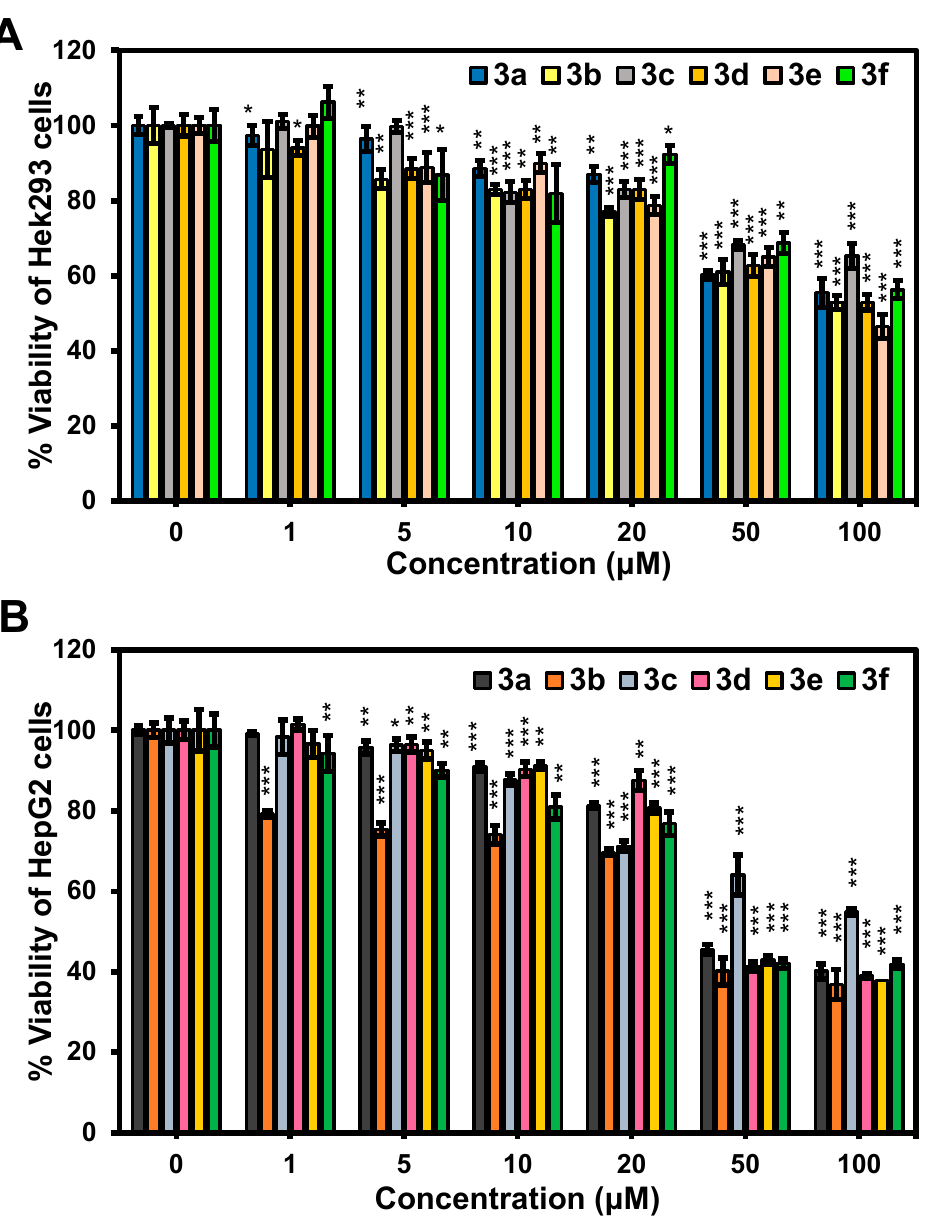
Figure 5. Cytotoxicity effect of chalcones 3a – f on the cellular viability of HEK-293 ( A ) and HepG2 ( B ). All cells were treated with chalcones 3a – f at different concentrations for 24 h (error bar represents standard deviation, n = 3). Statistical analysis is based on one-way ANOVA (* p < 0.05, ** p < 0.01, *** p < 0.001). Table 2. IC 50 of the chalcones ( 3a – f ).